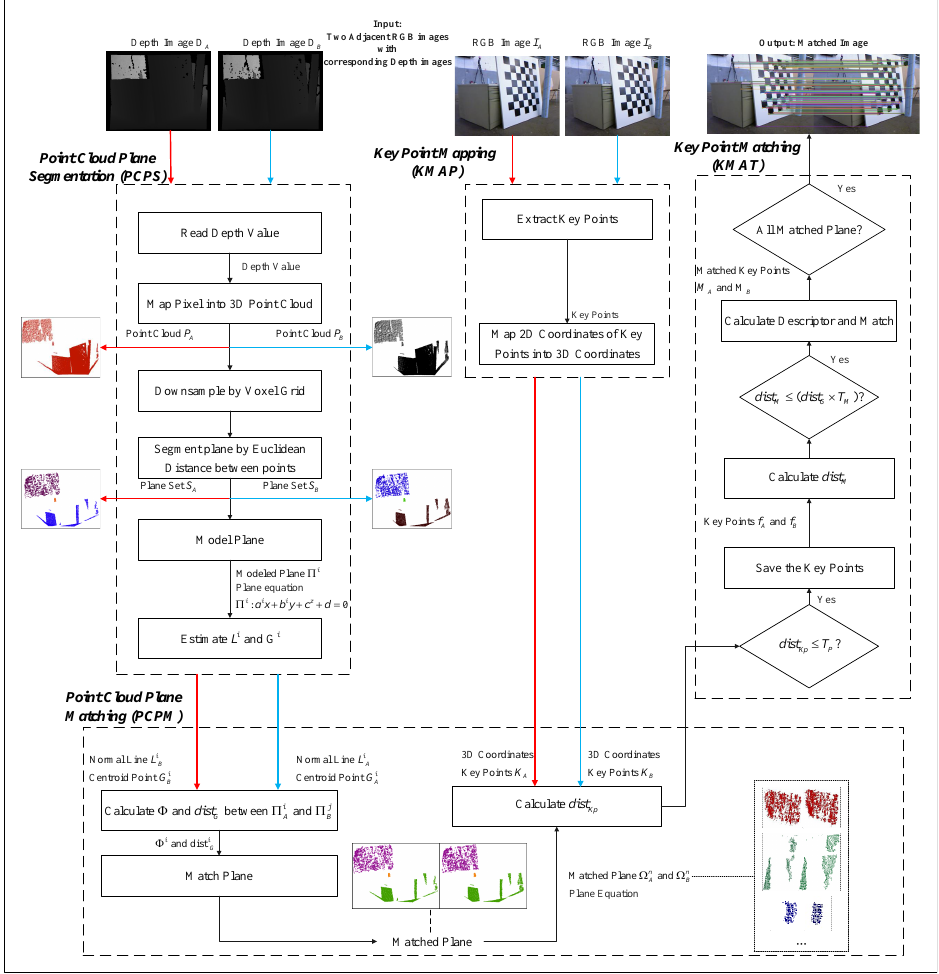
Figure 1. Flowchart of proposed IM_CPE. The PCPS transforms the input depth images into point clouds and segments the point clouds into planes. Then, the PCPS models the point cloud planes and estimates the normal vector and centroid of each plane. Meanwhile, the KMAP extracts key points on the input RGB image and maps the key points into 3-D coordinates. Next, the PCPM matches point cloud planes according to the angle of the normal vector and the distance between the centroid. When the planes are matched, the key points determine which plane they belong to. Next, the key points are coarsely matched according to their distance in 3-D coordinates and then fine matched by